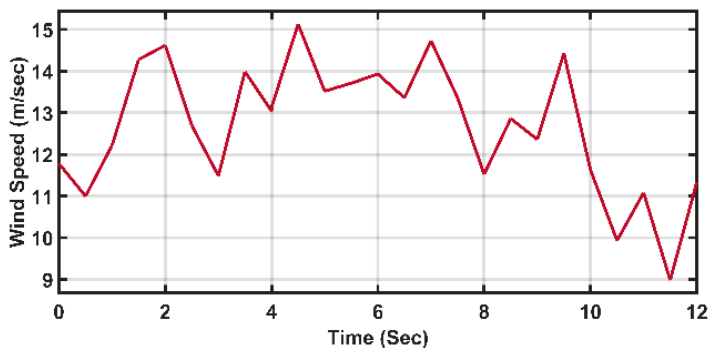
Energies 2021 , 14 , x FOR PEER REVIEW Figure 18. The wind-speed profile of normal third case. Figure 18. The wind-speed profile of normal third case.